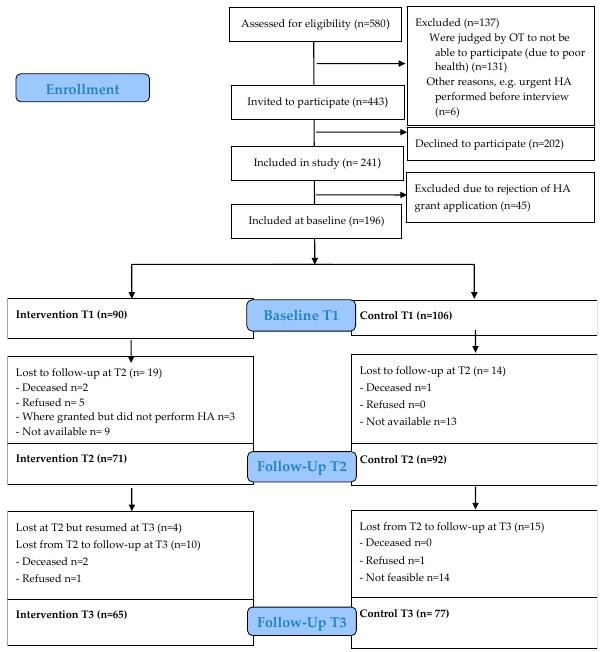
Figure 1. Consort flow chart for the trial.